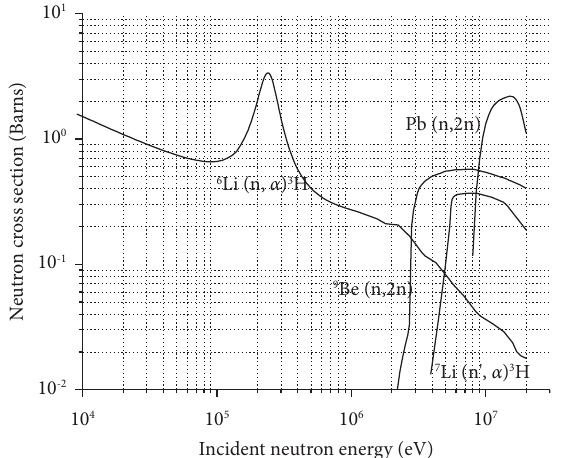
Figure 3: Cross-section for reactions 6 Li ( n , α ) 3 H, 7 Li ( n , nα ) 3 H, 9 Be ( n , 2 n ), and Pb ( n , 2 n )